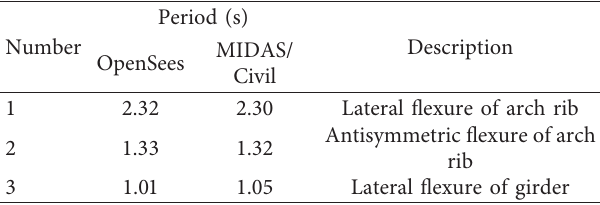
Table 2: Dynamic characteristics of the continuous beam-arch